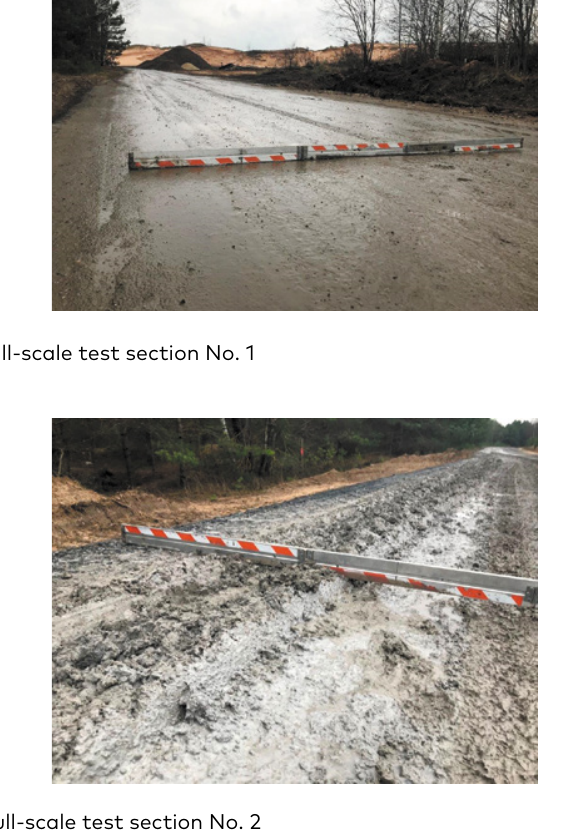
Figure 8. Full-scale test section No.